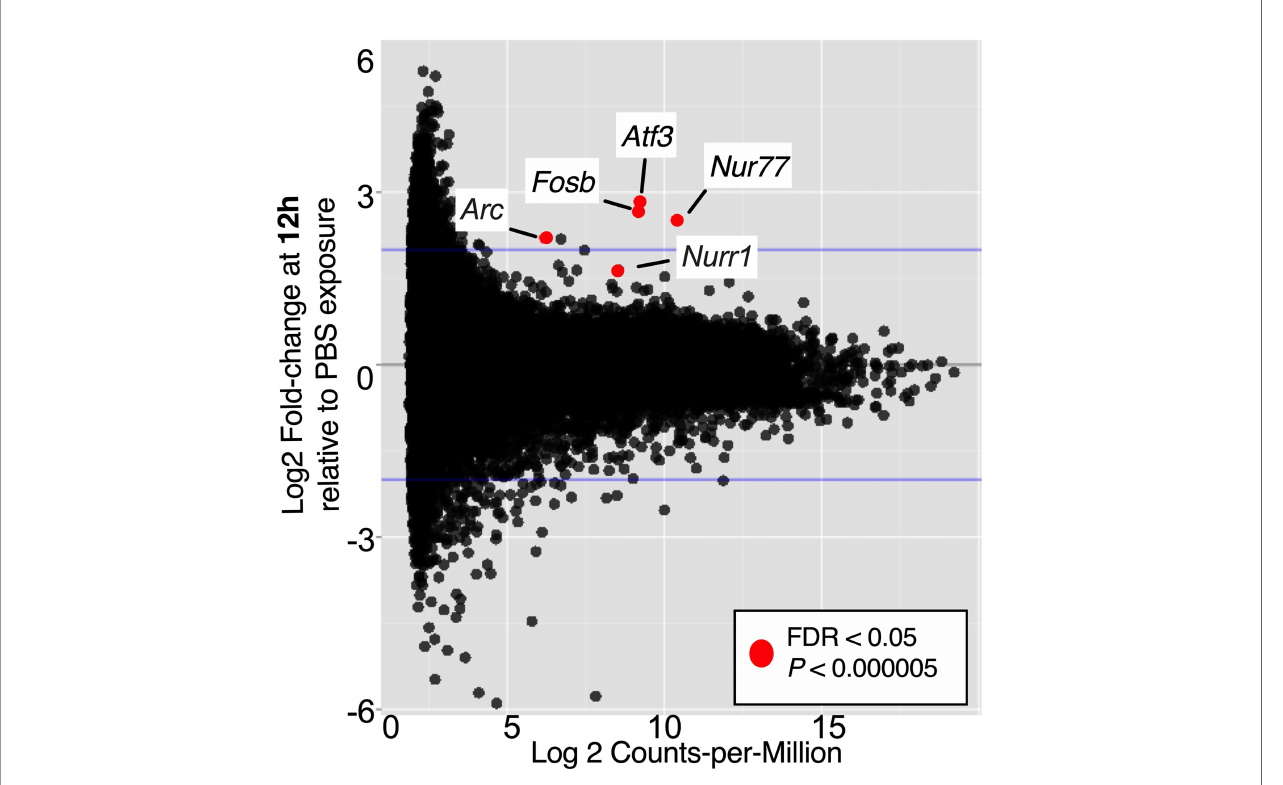
FIGURE 3 | Immediate Early genes upregulated in bladders 12 h after one Gardnerella exposure. The volcano plot indicates genes that had signi fi cantly higher expression in Gard -1 compared to PBS-1 bladders. FDR, false discovery rate correction for multiple